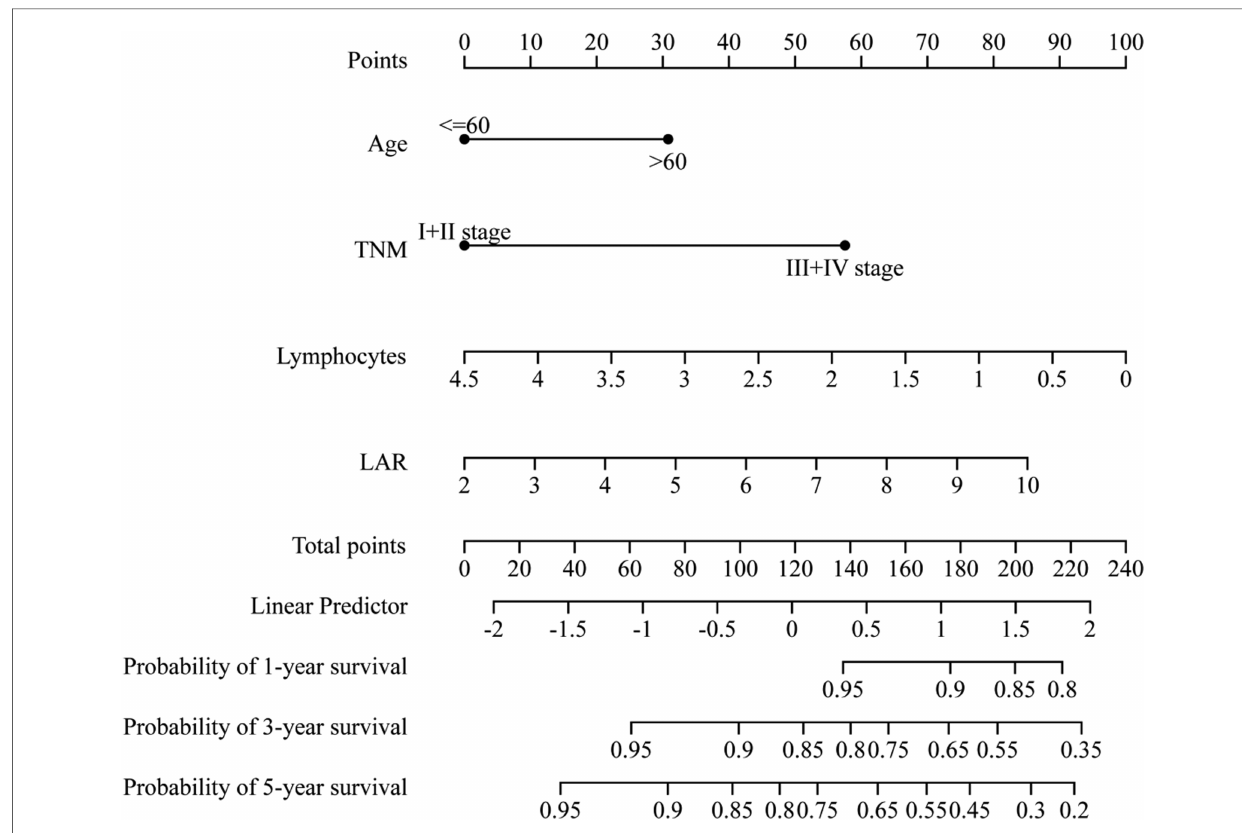
FIGURE 4 LAR-nomogram for predicting 1-year, 3- year and 5- year survival of CRC patients.